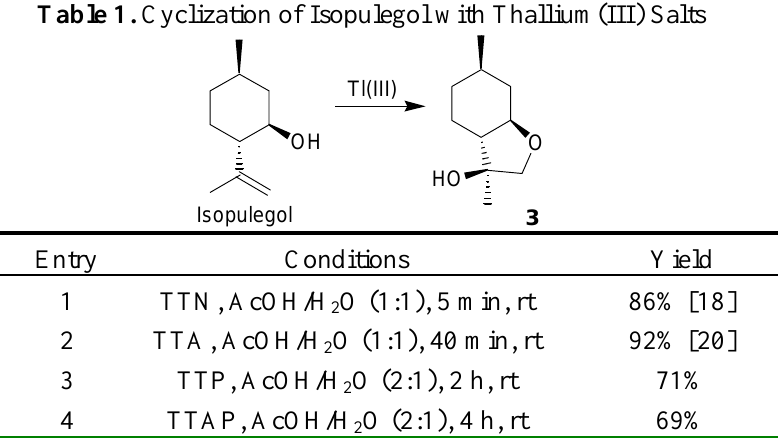
Table 1. Cyclization of Isopulegol with Thallium(III) Salts